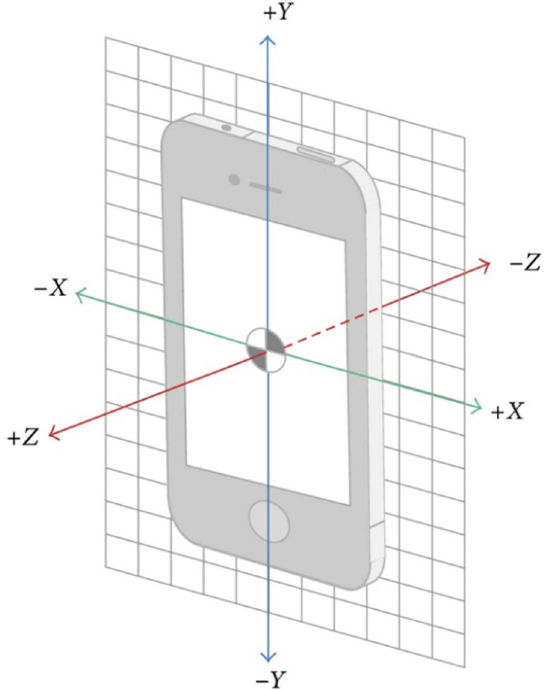
Fig. 2 Representation of the different axes of the smartphone accelerometer in